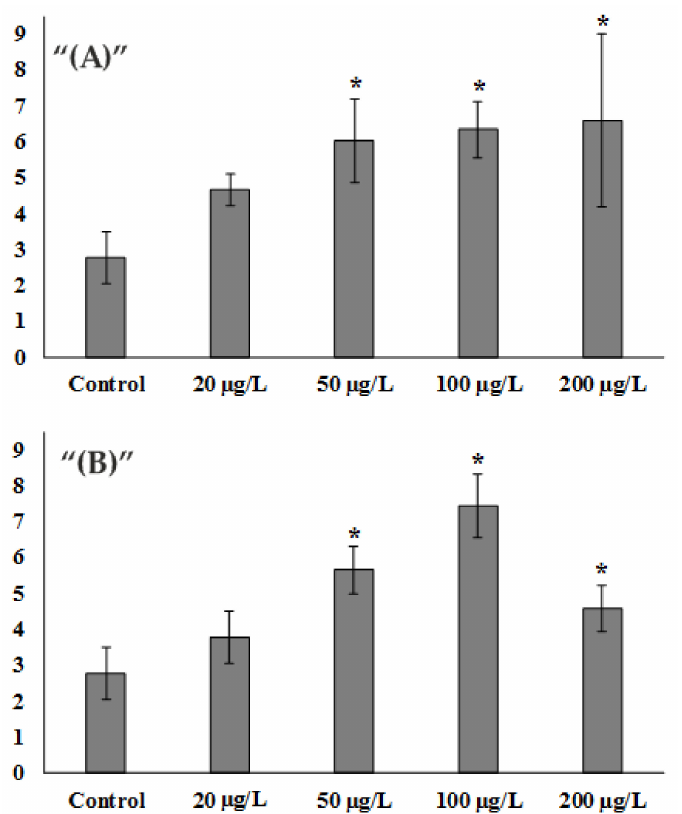
Figure 1. Assessment of S.mirabilis sperm DNA damage from control and experimental groups. ( A ) Zn 2+ exposure. ( B ) ZnO NPs exposure. (Mean ± standard deviation, N = 8, n = 400.) * Difference from the control is significant ( p <